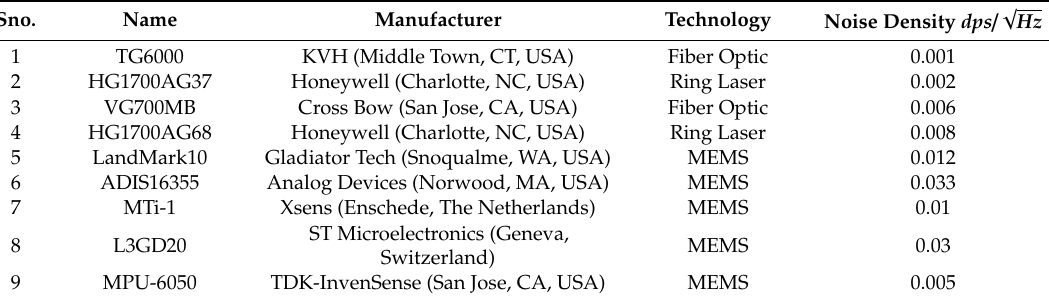
Table 1. Specifications comparison of di ff erent